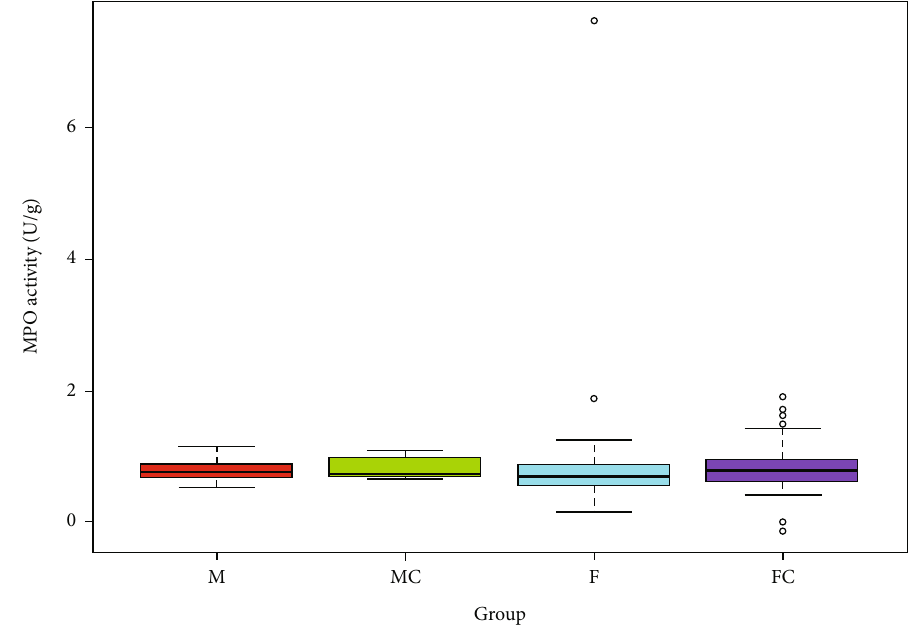
Figure 4: Comparison of myeloperoxidase (MPO) activity of colon tissue among groups. N = 8 per group.